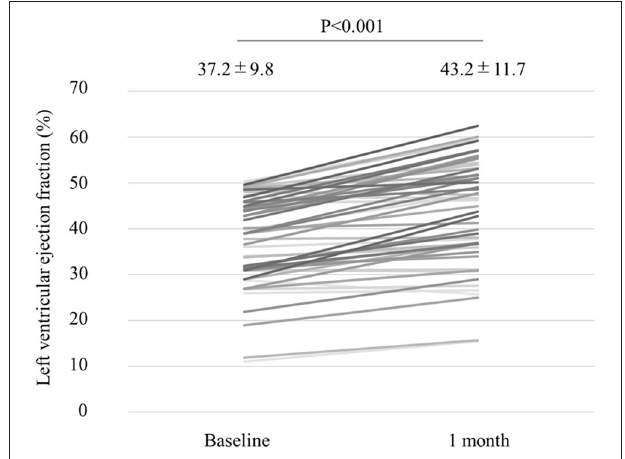
TABLE 1 | Patients’ characteristics.